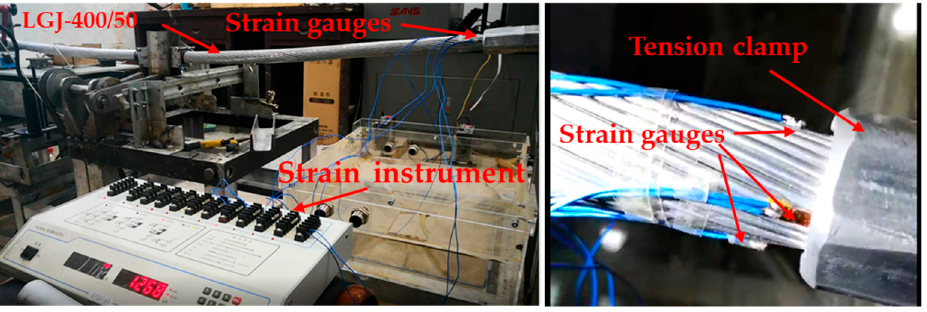
Figure 12. Installation positions of the strain gauges.